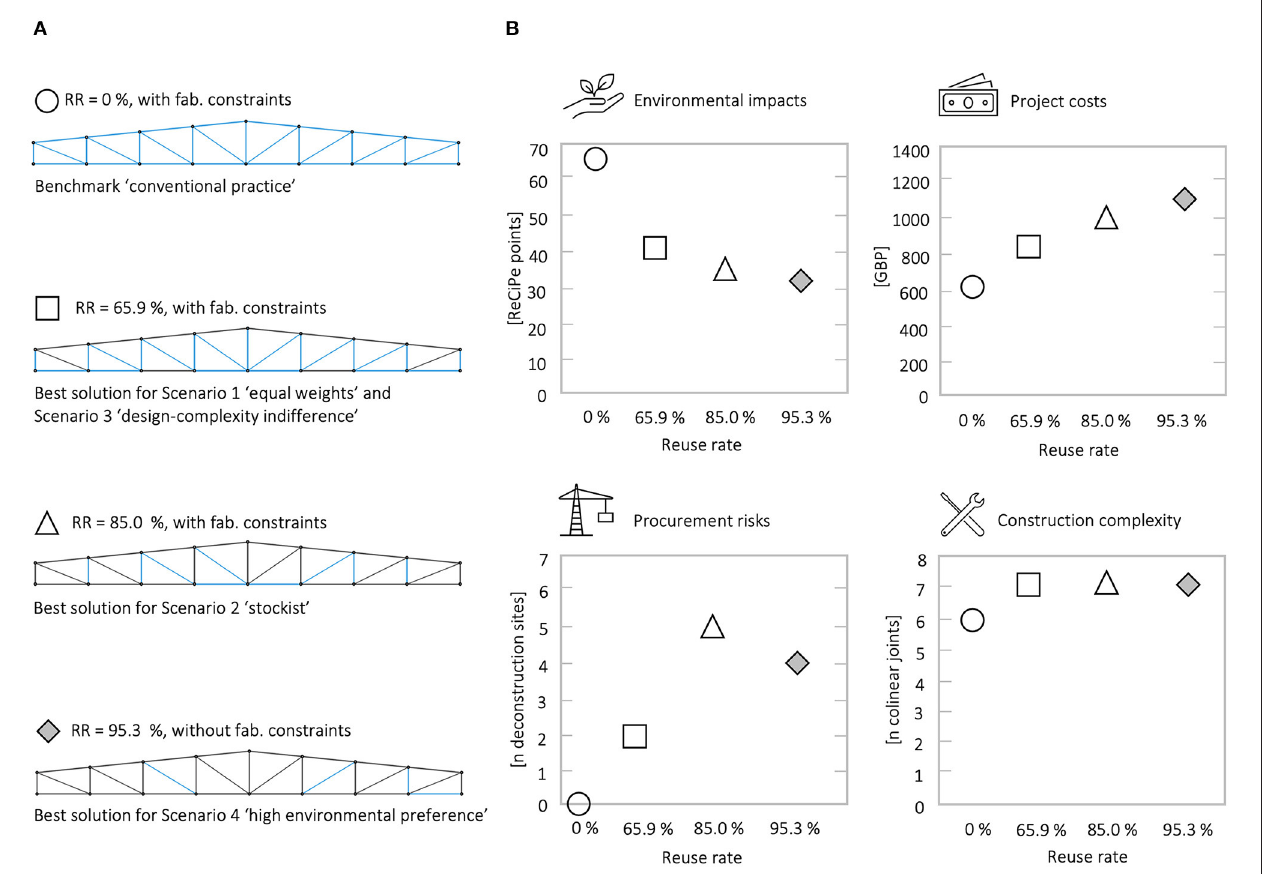
FIGURE 11 | Comparison of the benchmark and the recommended alternatives. (A) Summary of the design options. Dark-gray bars correspond to reused components and blue bars to new components; (B) evaluation of the four options for each performance